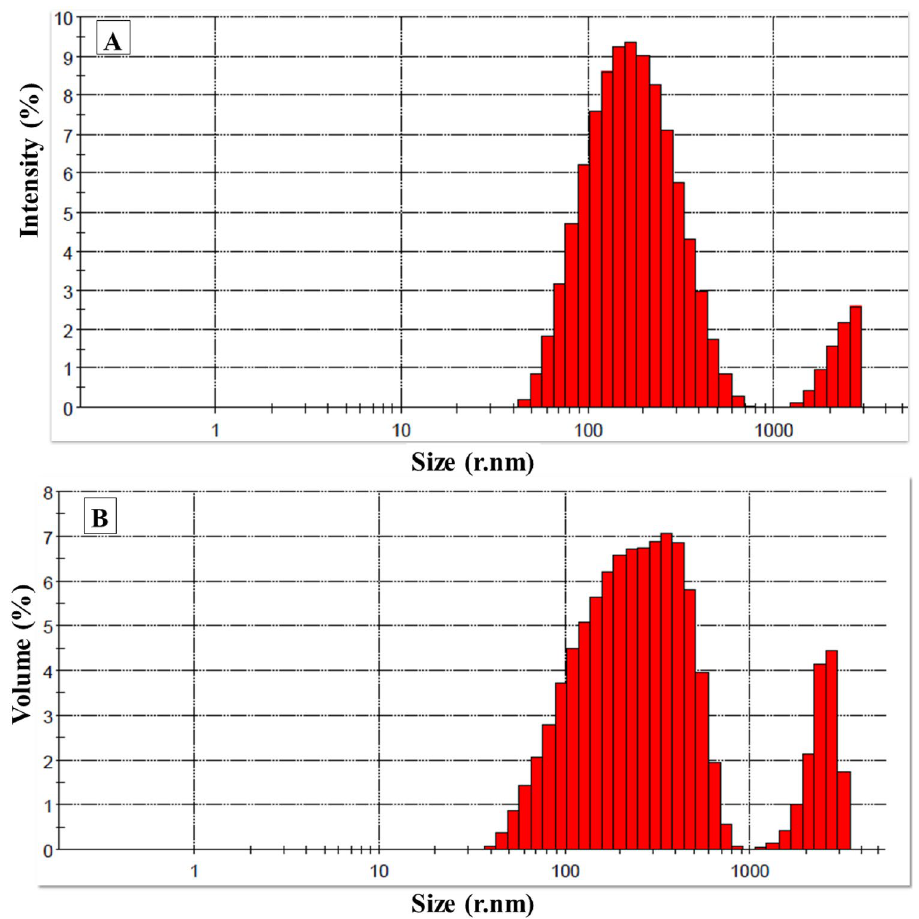
Figure 13. Size Distribution of Ag/AgONPs by ( A ) Intensity and ( B ) Volume. At Temperature 25 °C and Duration 60 s.